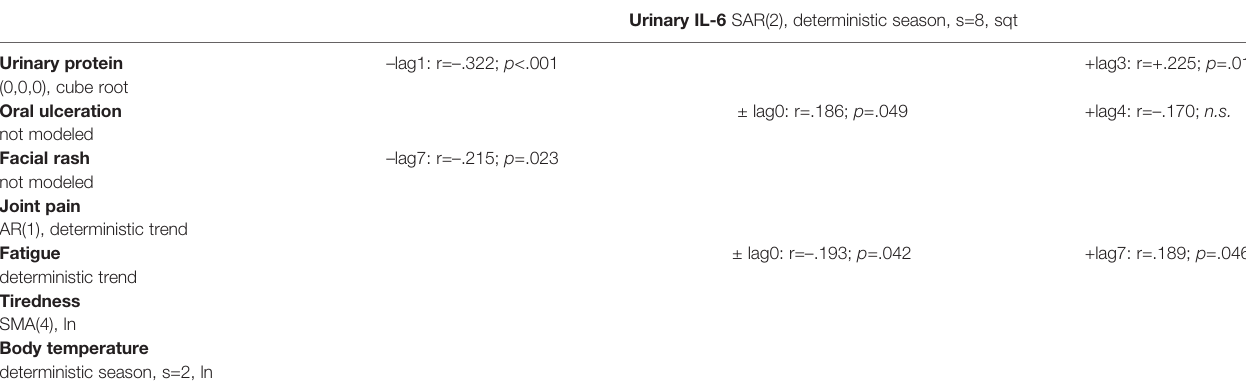
Urinary IL-6 SAR(2), deterministic season, s=8, sqt